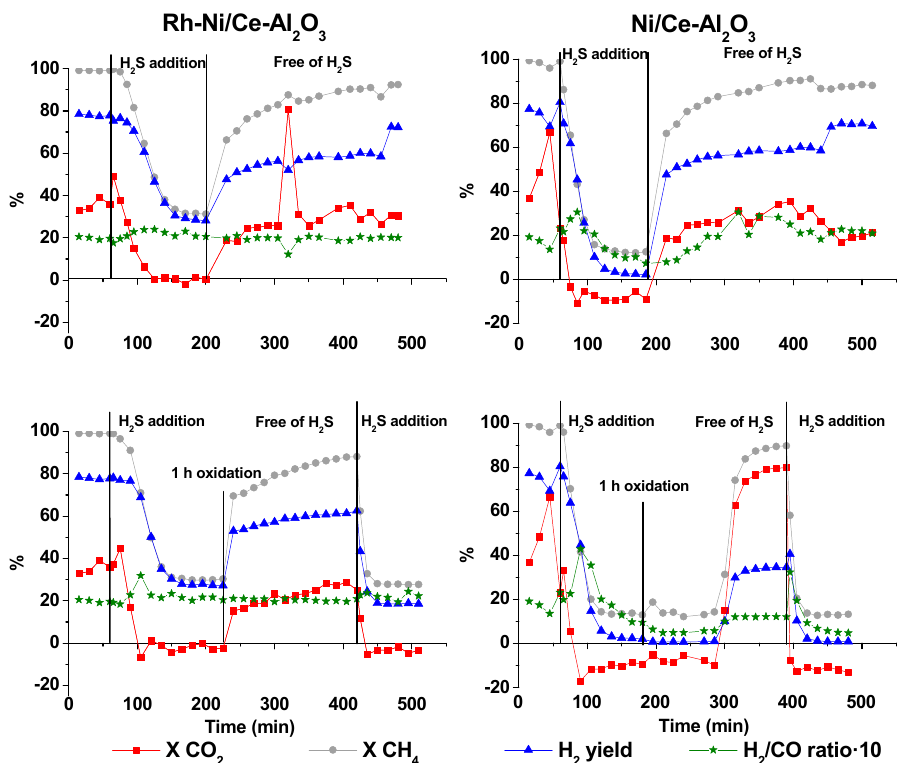
Figure 3. Ni/Ce ‐ Al 2 O 3 and Rh ‐ Ni/Ce ‐ Al 2 O 3 catalysts activity results. Top right : self ‐ regeneration of the Ni/Ce ‐ Al 2 O 3 catalyst. Bottom right : Regeneration by oxidation of the Ni/Ce ‐ Al 2 O 3 catalyst. Top left : self ‐ regeneration of the Rh ‐ Ni/Ce ‐ Al 2 O 3 catalyst. Bottom left : Regeneration by oxidation of the Rh ‐ Ni/Ce ‐ Al 2 O 3 catalyst. Reaction conditions: 210.0 mL/min CH 4 , 140.0 mL/min CO 2 , 197.7 mL/min N 2 , 52.5 mL/min O 2 , 0.169 mL/min H 2 O at 800 °C and atmospheric pressure. WHSV of 161.5 g gas g cat − 1 h − 1 (0.340 g of catalyst).